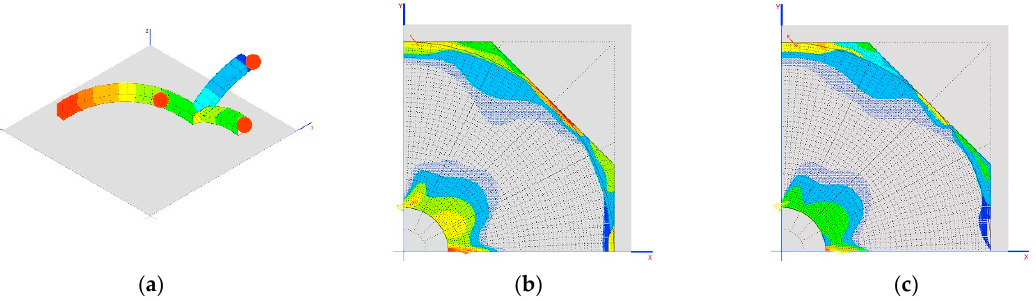
Figure 8. ( a ) Situation of the worst sections for the axial stress of the structural stone arches; ( b ) location of traction in the dome for the 120 mm crosspiece, up to 0.852 MPa; ( c ) location of traction in the dome for the 40 mm crosspiece, up to 0.856 MPa.